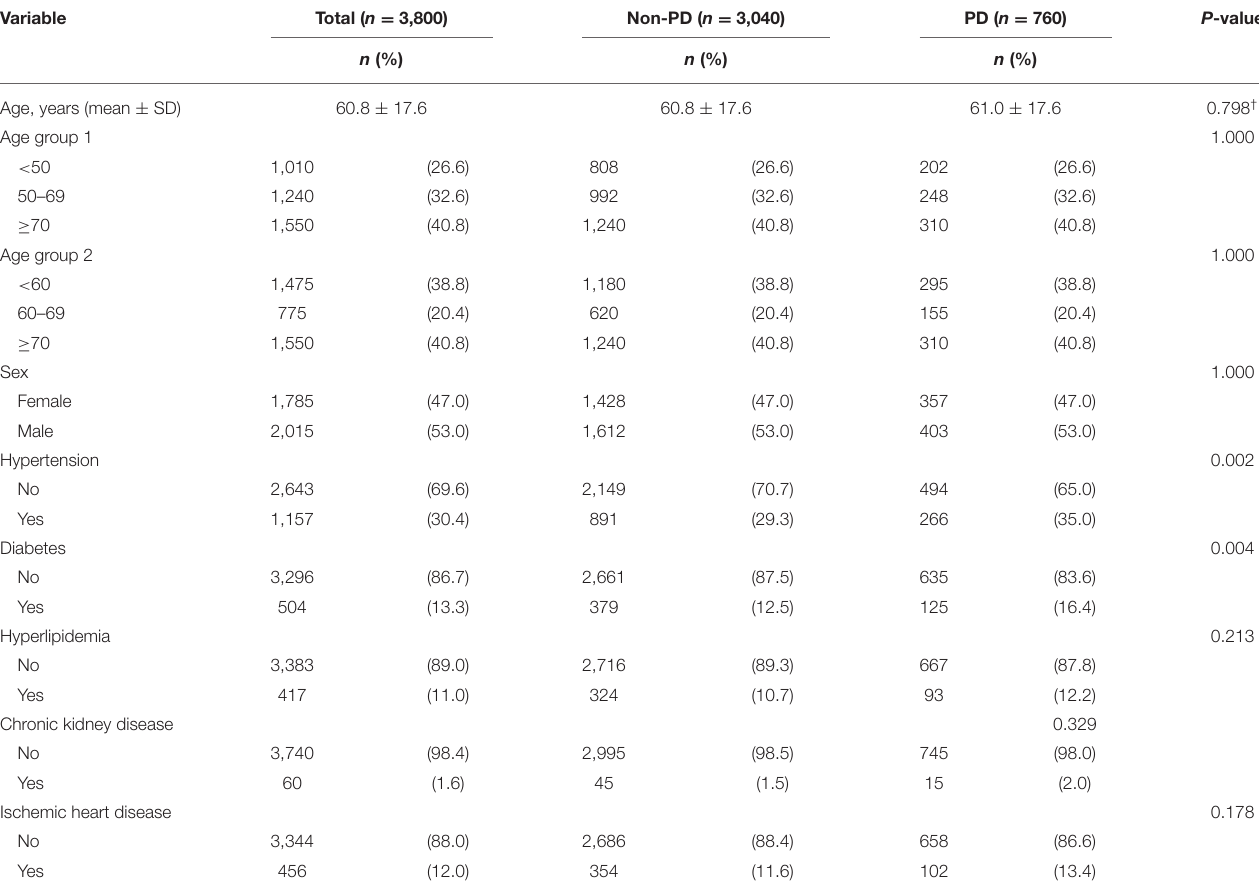
TABLE 1 | Baseline clinical characteristics of study subjects with and without PD.